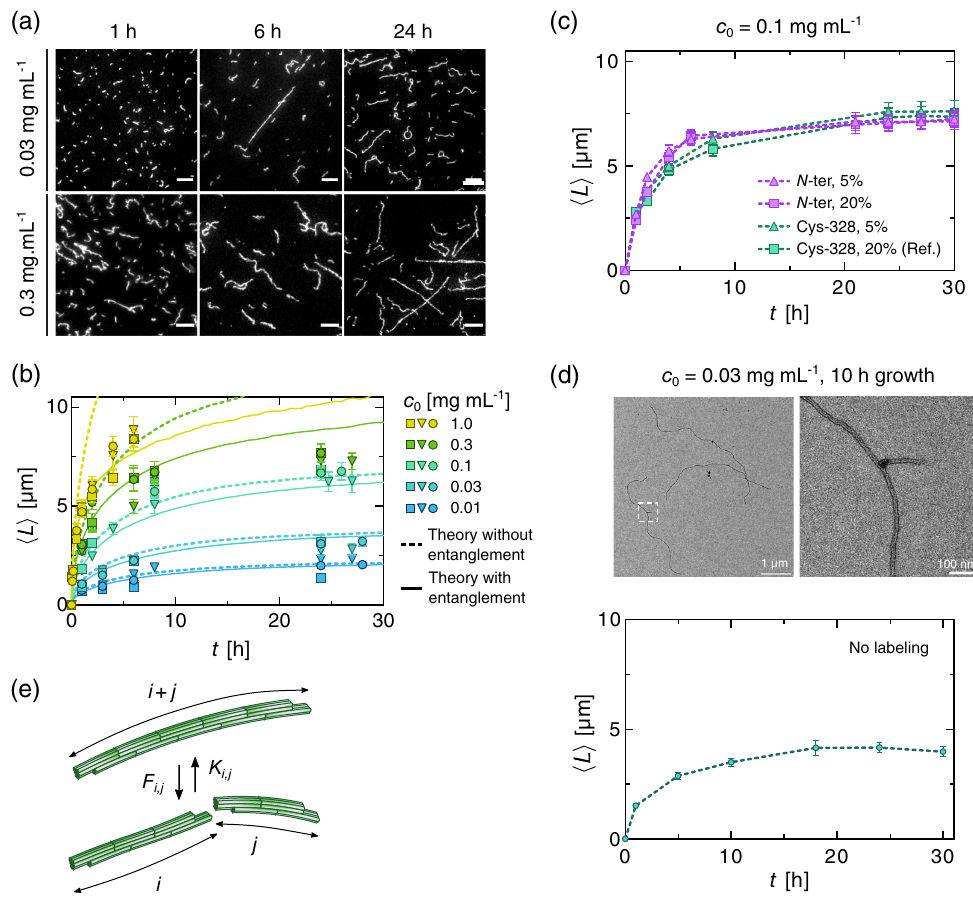
FIG. 1. Filament length reaches a plateau during vimentin assembly. (a) Fluorescence images of in vitro vimentin filaments polymerized in assembly buffer at different initial concentrations, for a duration up to 28 h at 37 °C. For 0 . 03 mg mL − 1 , filaments were fixed by mixing them with an equal volume of glutaraldehyde 0.5%. For 0 . 3 mg mL − 1 , filaments were first diluted 20 times in assembly buffer before being fixed. Scale bar: 5 μ m. (b) Graph of the mean length h L i of vimentin filaments at different initial concentrations c 0 over time. The dashed lines correspond to theoretical fits from the model without entanglement, and the solid lines from the model with entanglement. Both fits were obtained via numerical simulations. The condition assembled at 0 . 1 mg mL − 1 was used as a reference for (c). (c) Graph of the mean length h L i of filaments assembled at the initial concentration of 0 . 1 mg mL − 1 with different fluorescence labeling methods (succinimide ester which mostly reacts with vimentin N-terminal NH2 groups and maleimide which reacts with the cysteine-328) and labeling rates over time. (d) Transmission electron microscopy image of unlabeled vimentin filament assembled at initial concentration of 0 . 03 mg mL − 1 for duration of 10 h at 37 °C and enlargement of the boxed region. Graph of the mean length of unlabeled vimentin filaments as a function of time. Each data point in (b) – (d) represents the average over 200 filaments and error bars represent the standard error of the mean. (e) Schematics illustrating the annealing at rate K and fragmentation at rate F used in the i;j i;j theoretical